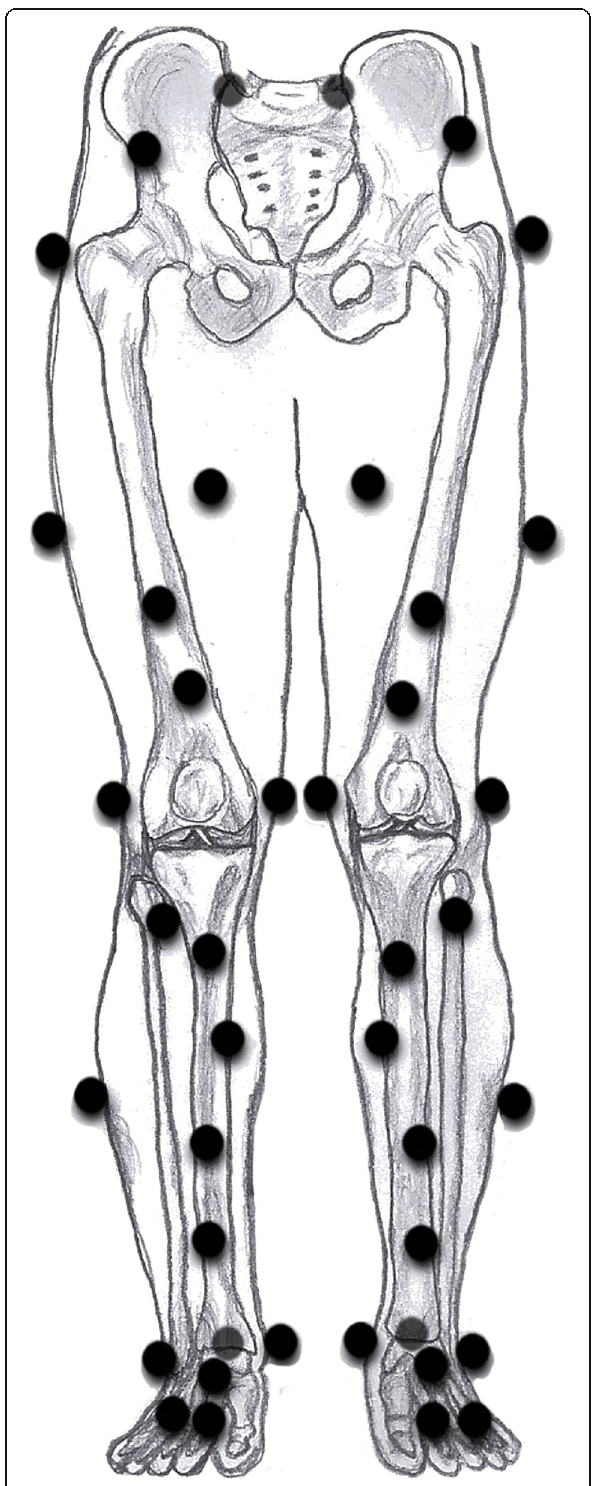
Fig. 1 Marker placement. Markers were attached on the right and left anterior and posterior superior iliac spine, the right and left iliac crest, the greater trochanter, the medial and lateral epicondyles of the knee, the medial and lateral malleoli of the ankle, the heel, anterior of the talus bone and the first and fifth metatarsophalangeal joints. Besides, two additional markers were attached to the pelvis, two to the thigh, and six additional markers were attached to the shank (adapted from Boeth et al.